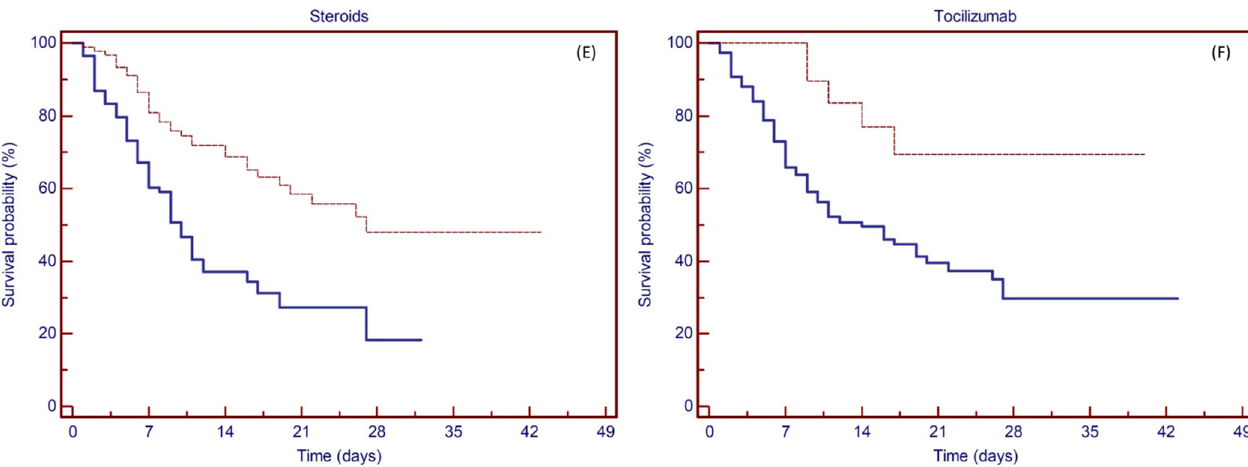
Figure 4. Kaplan–Meier plots showing the probability of survival based on treatments. ( A ) Patients treated with low-flux (solid line) or high-flux (dashed line) oxygen therapy. O2 therapy showed prognostic significance for survival ( p < 0.0001), with an estimated 28-day survival rate of 50.0% and 23.3%, respectively. ( B ) No anticoagulation therapy (solid line) vs. LMWH at prophylaxis dose (dashed line) or therapeutic dose (dotted line). LMWH treatment showed prognostic significance for survival ( p = 0.0001), with an estimated 28-day survival rate of 23.8%, 36.9%, and 37.1%, respectively. ( C ) No HCQ (solid line) vs. HCQ treatment (dashed line). HCQ showed prognostic significance for survival ( p = 0.0029), with an estimated 28-day survival rate of 27.3% and 35.7%, respectively. ( D ) No antiviral (solid line) vs. antiviral treatment (dashed line). Antiviral therapy showed prognostic significance for survival ( p < 0.0001), with an estimated 28-day survival rate of 22.4% and 60.1%, respectively. ( E ) No steroid (solid line) vs. steroid treatment (dashed line). Steroid therapy showed prognostic significance for survival ( p < 0.0001), with an estimated 28-day survival rate of 18.2% and 47.9%, respectively. ( F ) No tocilizumab (solid line) vs. tocilizumab treatment (dashed line). Tocilizumab therapy showed prognostic significance for survival ( p = 0.0059), with an estimated 28-day survival rate of 29.6% and 69.4%, respectively.